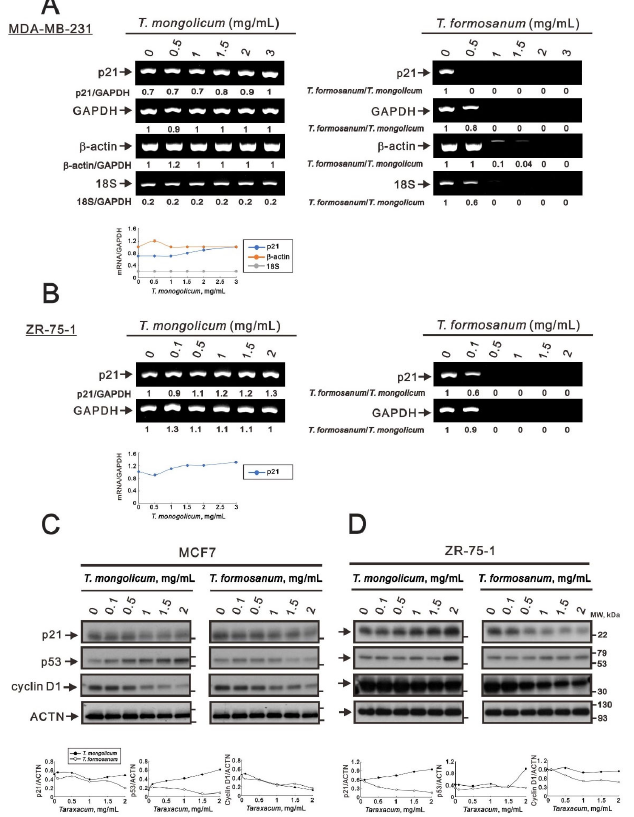
Figure 9. Effects of T. mongolicum and T. formosanum on transcriptional regulation in MDA ‐ MB ‐ 231 cells. ( A ) MDA ‐ MB ‐ 231 and ( B ) ZR ‐ 75 ‐ 1 cells were treated for 24 h with the indicated concentrations of T. mongolicum or T. formosanum , after which their cell lysates were subjected to RT ‐ PCR analysis using primer pairs against p21 mRNA, with GAPDH and β‐ actin mRNAs serving as mRNA loading controls and 18S rRNA as an internal control. ( C,D ) Western blot analysis using antibodies against the indicated proteins, with ACTN serving as the protein loading control. mRNA and protein bands were quantified through pixel density scanning and evaluated using ImageJ, version 1.44a (http://imagej.nih.gov/ij/)(accessed on 25 July 2022). The values of the GAPDH mRNA of T. mongolicum were calculated with the vehicle only, and other values were calculated as the indicated ratio.